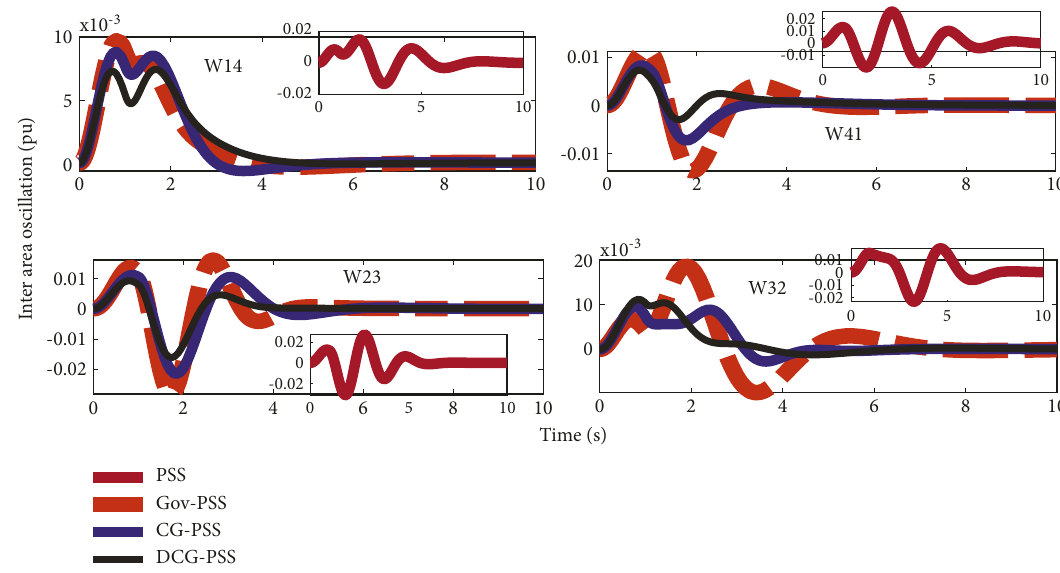
Figure 14: Inter-area oscillation of ω